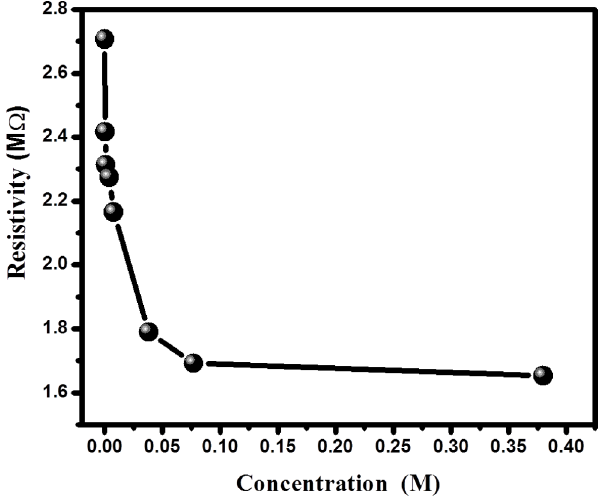
Figure 6. Resistivity of sensor toward phthalimide concentra- tion.